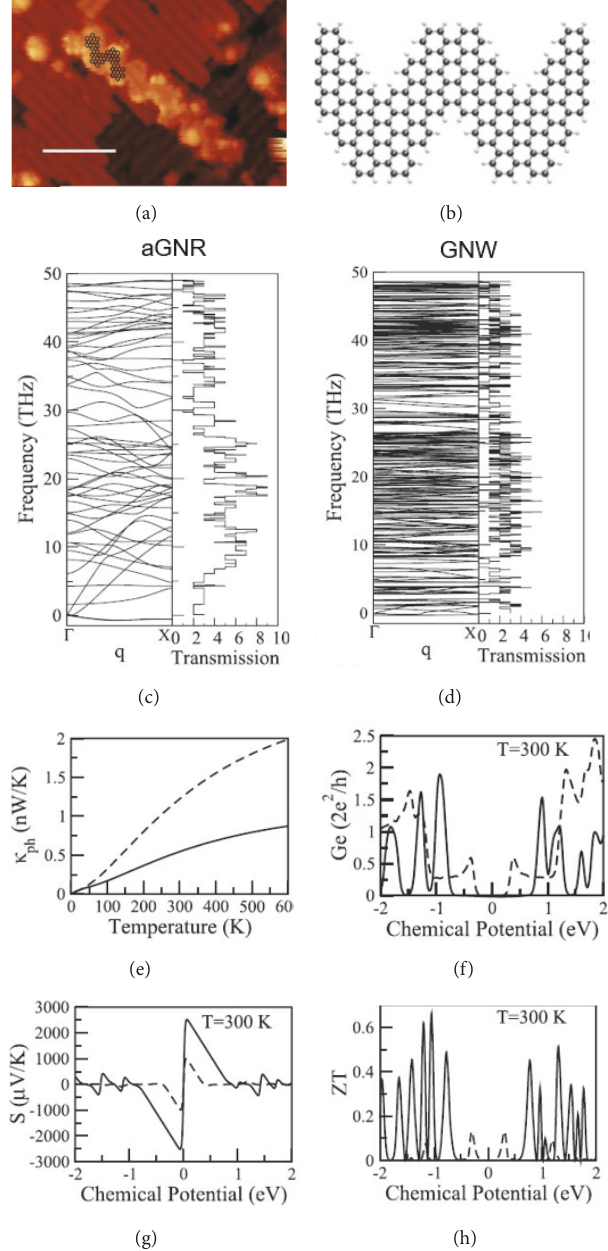
Figure 7: (a) Scanning tunneling microscopy image of graphene nanowiggle. (b) Atomic structure of GNW. ((c) and (d)) Phonon dispersion relations and transmission functions of aGNR and its GNW counterpart. (e) Thermal conductance as a function of temperature for aGNR and the GNW shown in panel (b). (f)–(h) Electrical conductance G e , Seebeck coefficient S, and TE figure-of-merit ZT as a function of chemical potential at room temperature for aGNR and GNW. In panels (e)–(h), solid lines denote GNW and dashed lines denote the corresponding aGNR. All panels are reproduced with permission [103,